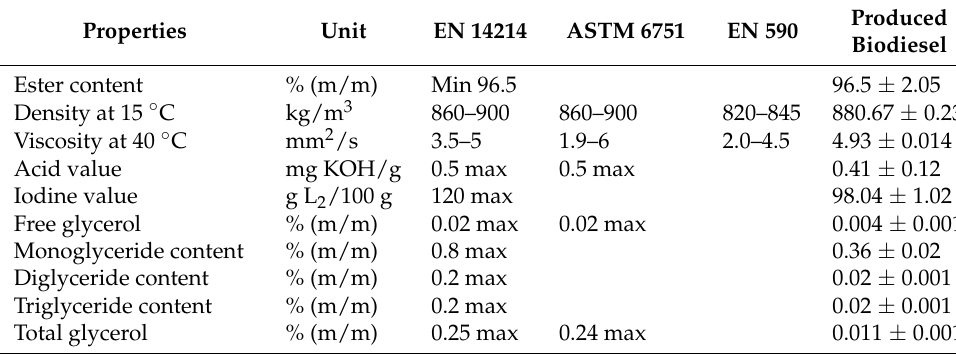
Table 6. Properties of biodiesel and requirements of